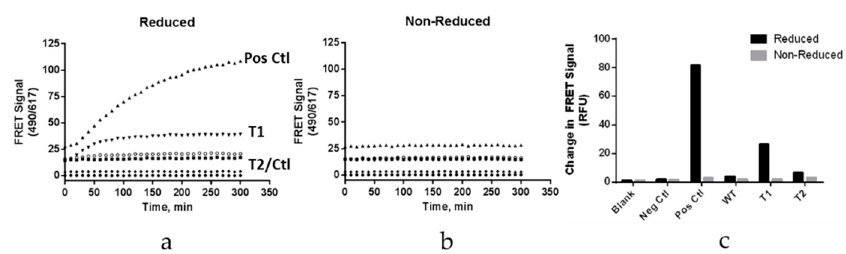
Figure 7. Blocking Fab arm exchange of hinge deleted mAbs by CH3 stabilization monitored by